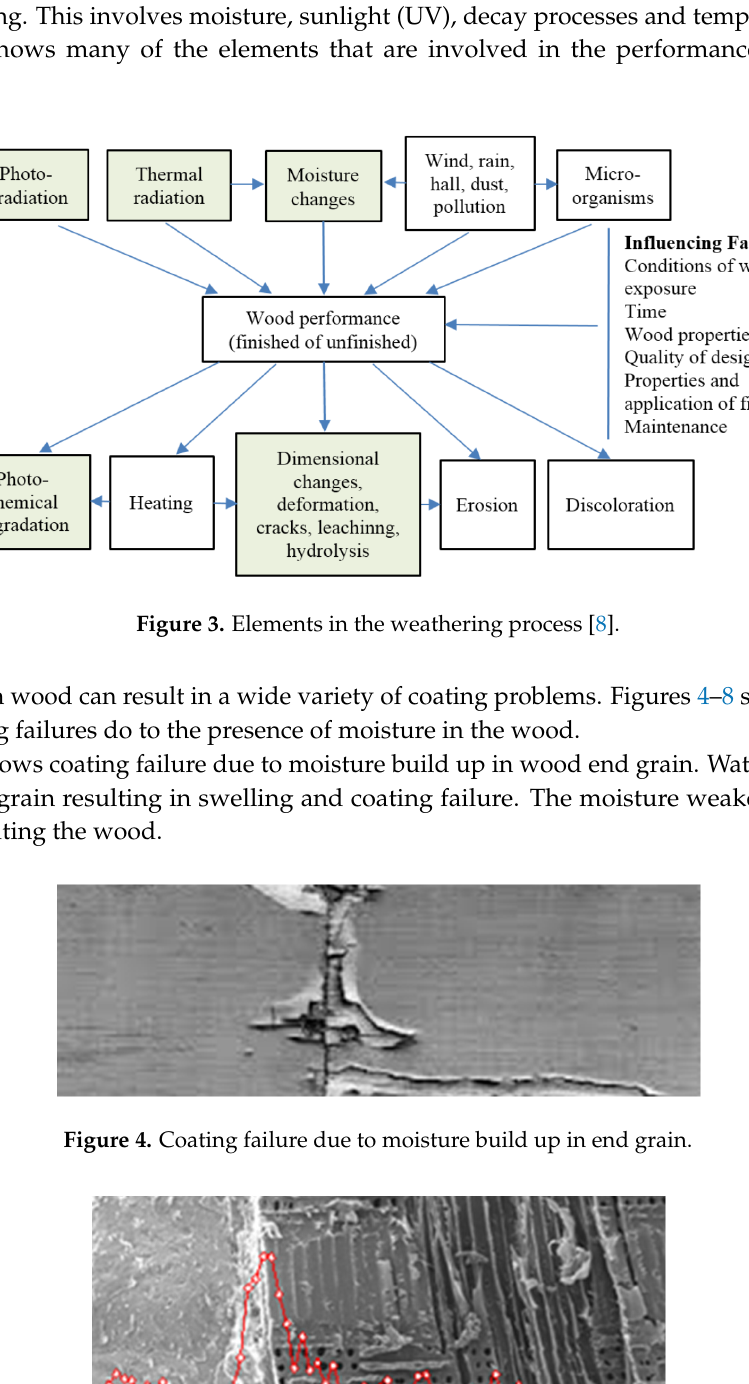
Figure 5. Buildup of moisture at the interface of wood and coating (red line) [1].